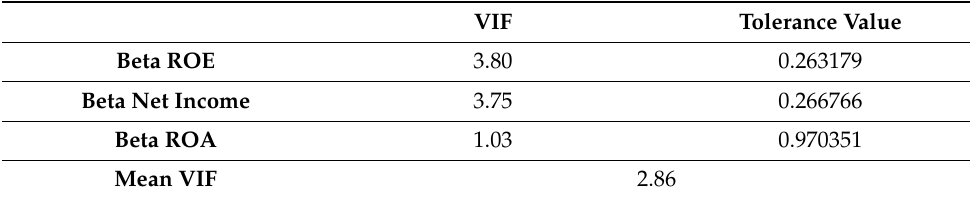
Table 4. Multicollinearity